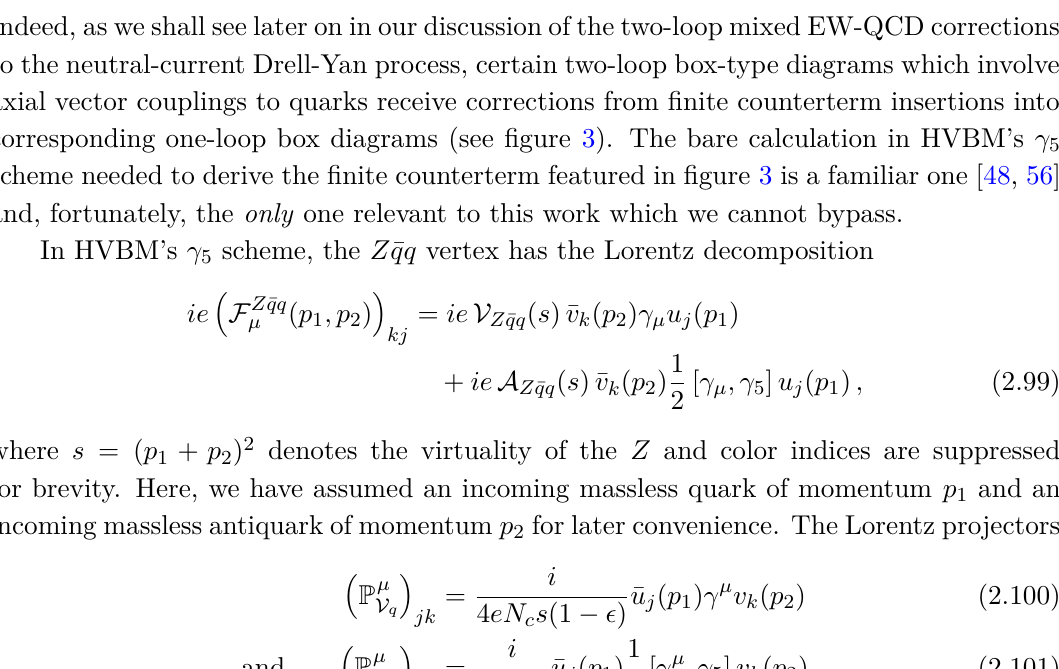
Figure 4 . The order α s gluon-exchange correction to the Z ¯ qq vertex form